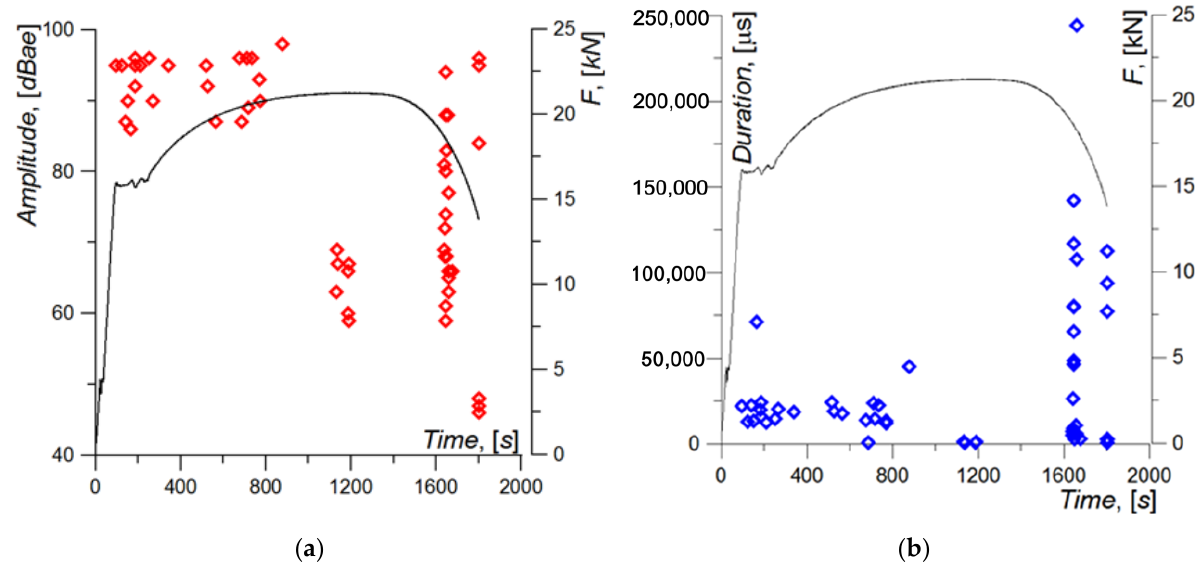
Figure 11. Characteristics of the AE signal recorded during specimen loading: ( a ) Amplitude; ( b ) Duration.